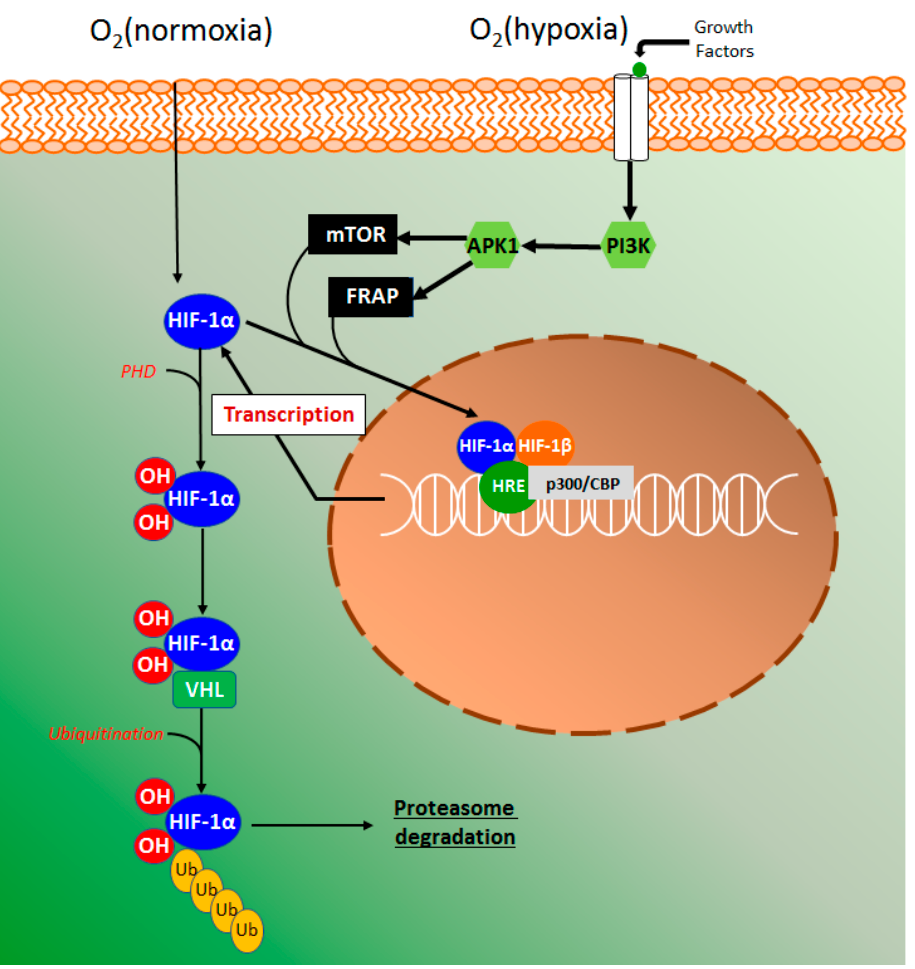
Figure 10. The hypoxia-inducible factor 1 alpha (HIF-1 α ) signaling pathway of intestinal inflammation as the target for the action of esculetin.